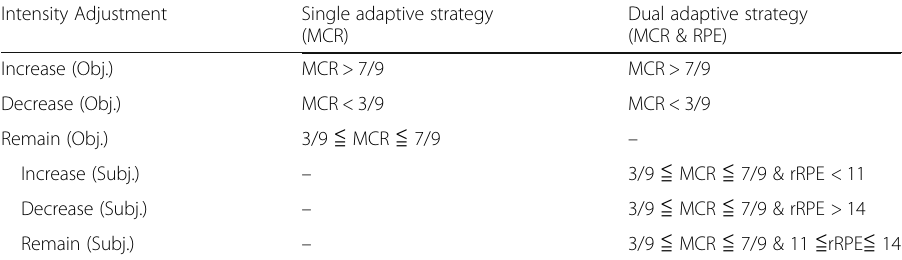
Table 3 The adaptive strategies for adjusting exercise intensity levels Intensity Adjustment Single adaptive strategy Dual adaptive strategy (MCR) (MCR & RPE) Increase (Obj.) MCR > 7/9 MCR > 7/9 Decrease (Obj.) MCR < 3/9 MCR < 3/9 Remain (Obj.) 3/9 ≦ MCR ≦ 7/9 – Increase (Subj.) – 3/9 ≦ MCR ≦ 7/9 & rRPE < 11 Decrease (Subj.) – 3/9 ≦ MCR ≦ 7/9 & rRPE > 14 Remain